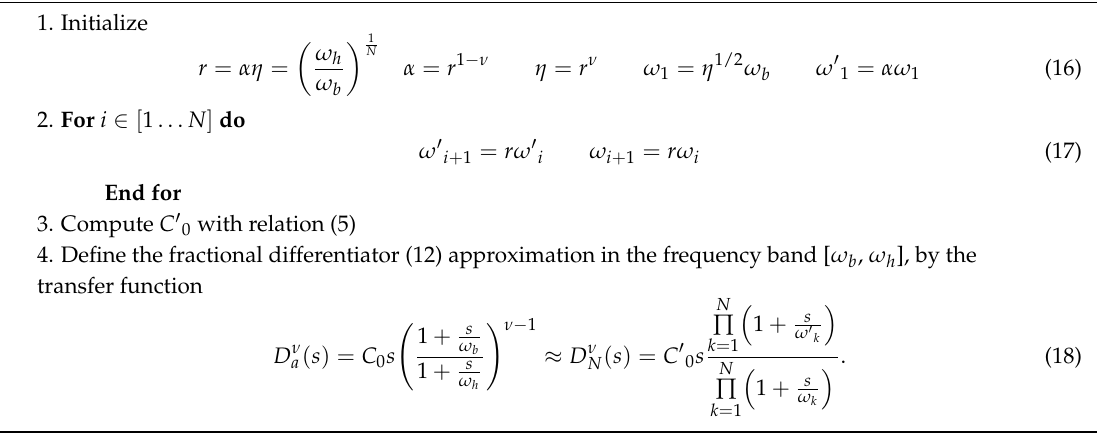
Algorithm 4. Fractional differentiator approximation—second